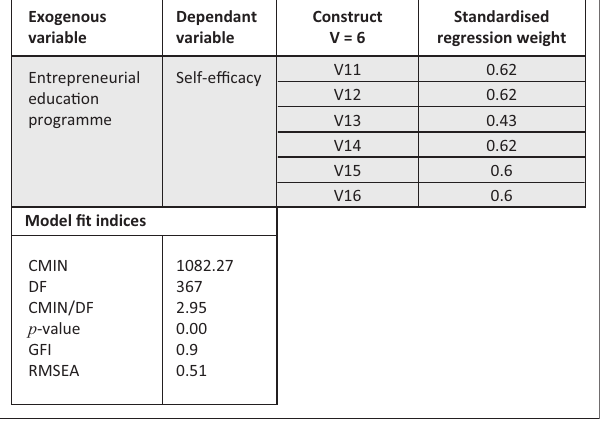
FIGURE 2: Model fit indices.